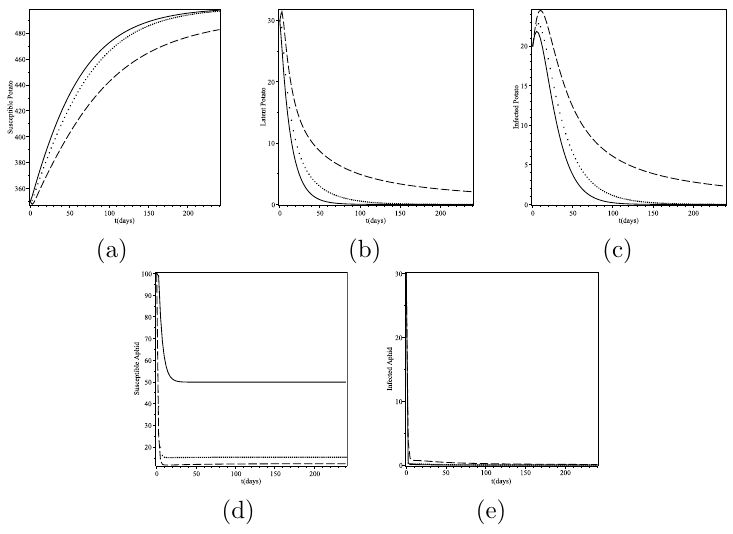
Figure 8. The host and vector population dynamics under different situations where u 3 (cid:54) = 0. When mixed-cropping combined with mineral oil is used (solid), mixed-cropping with insecticide (dotted), and mineral oil combined with insecticide but without mixed-cropping, i.e., Q = 0